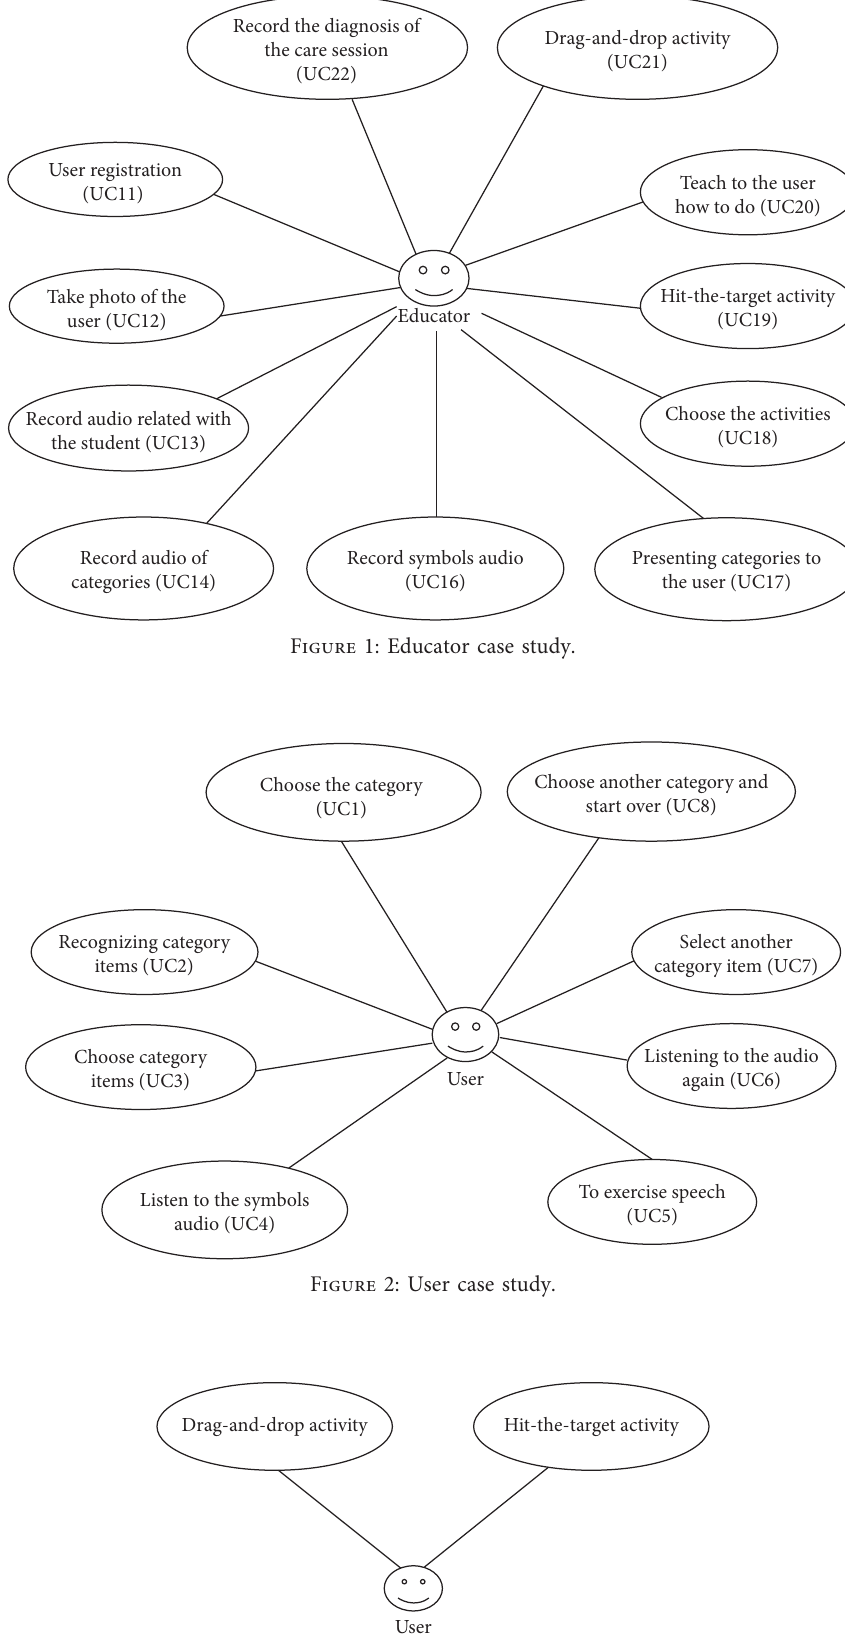
Figure 3: Student